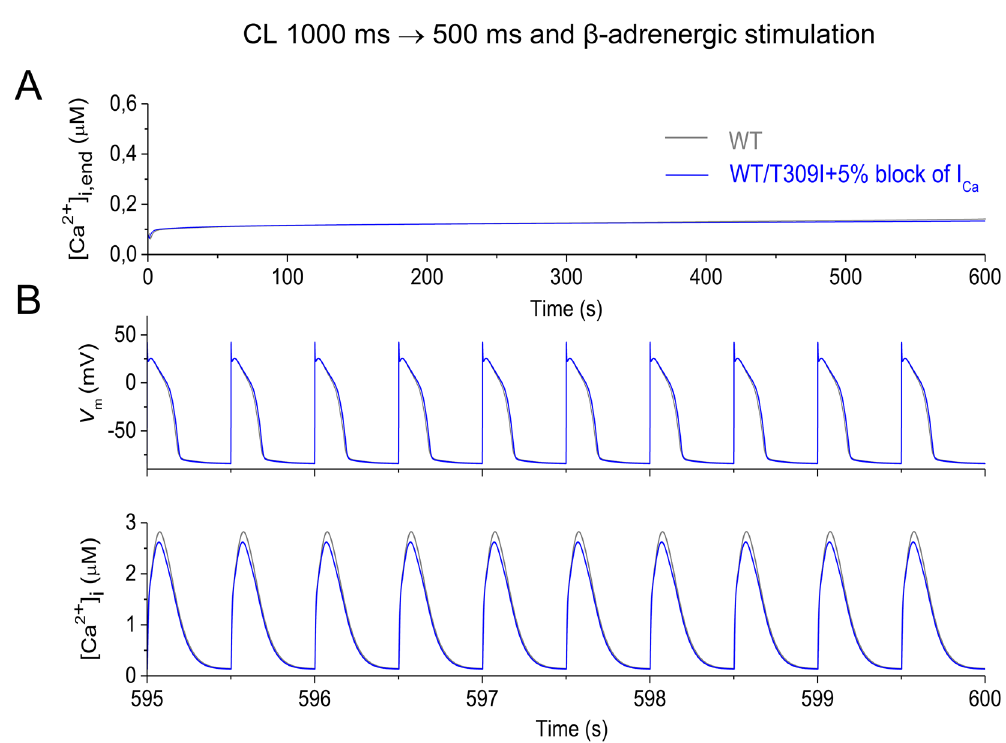
Figure 2. A correct version of the original Figure